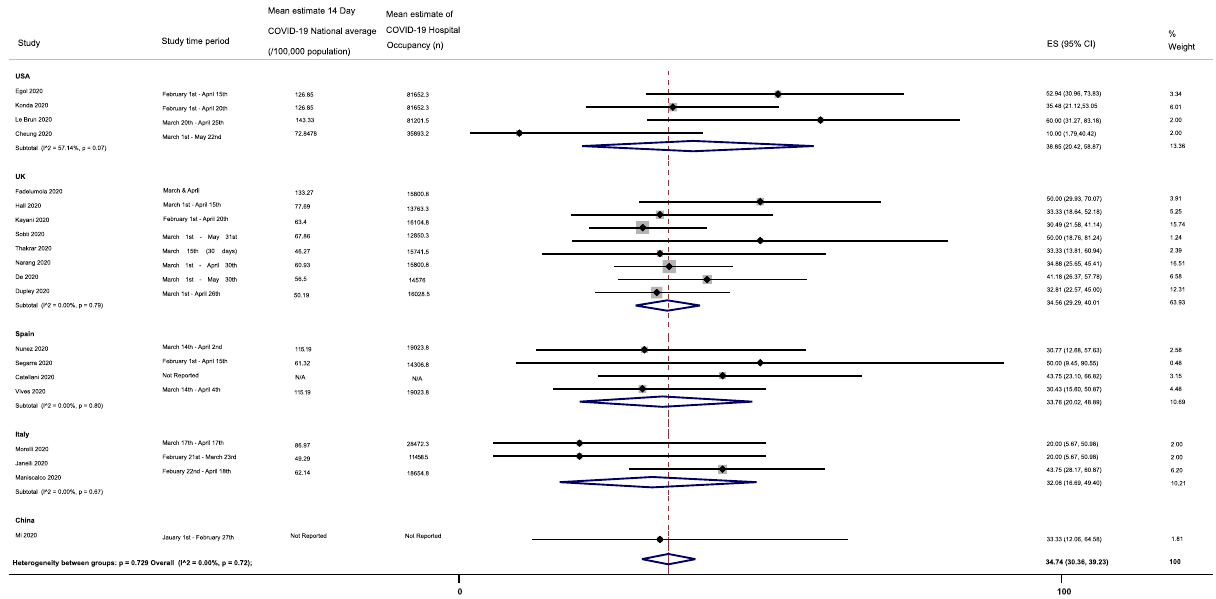
Figure 6. Shows the forest plot for case fatality rates (CFR) for COVID-19 positive patients. Covariates Regression coefficient SE 95% CI for coefficient P value 14-day average COVID-19 positive cases during the time Case fatality rate